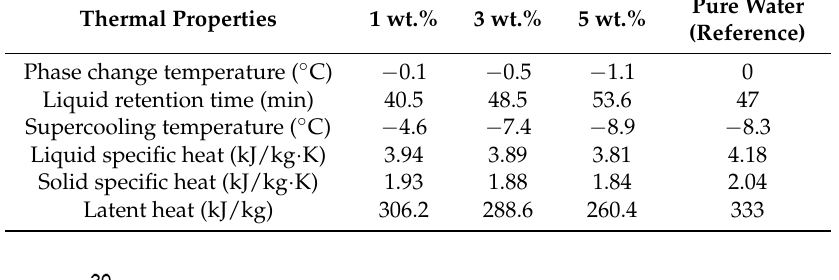
Table 2. Summary of thermal properties of PCMs with different eutectic molten salt concentrations; 1 wt.%, 3 wt.% and 5 wt.% without SAP.